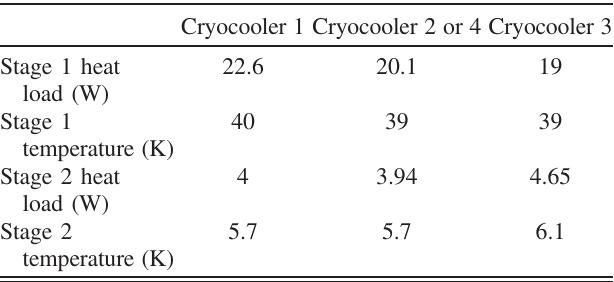
TABLE II. Summary of the heat loads and temperatures of the cryocoolers.